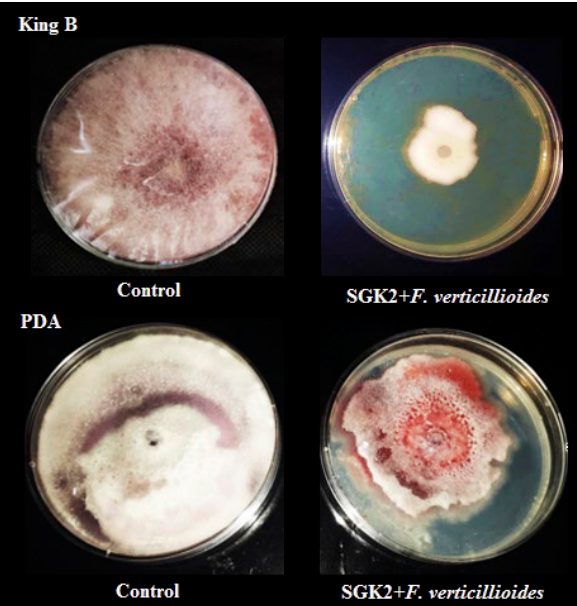
Figure 1. Direct confrontation test between Paenibacillus polymyxa SGK2 and Fusarium verticillioides on the King’s B and PDA media after 7 d incubation at 28°C in the dark.